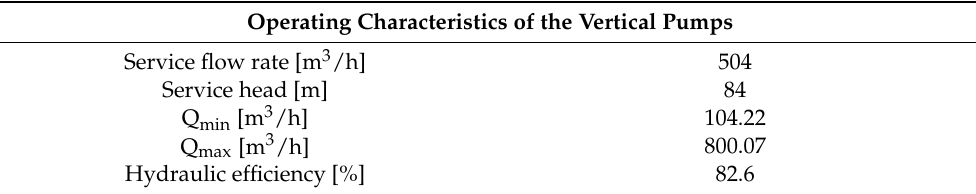
Table 2. The operating characteristics of the vertical pumps from the pumping group.